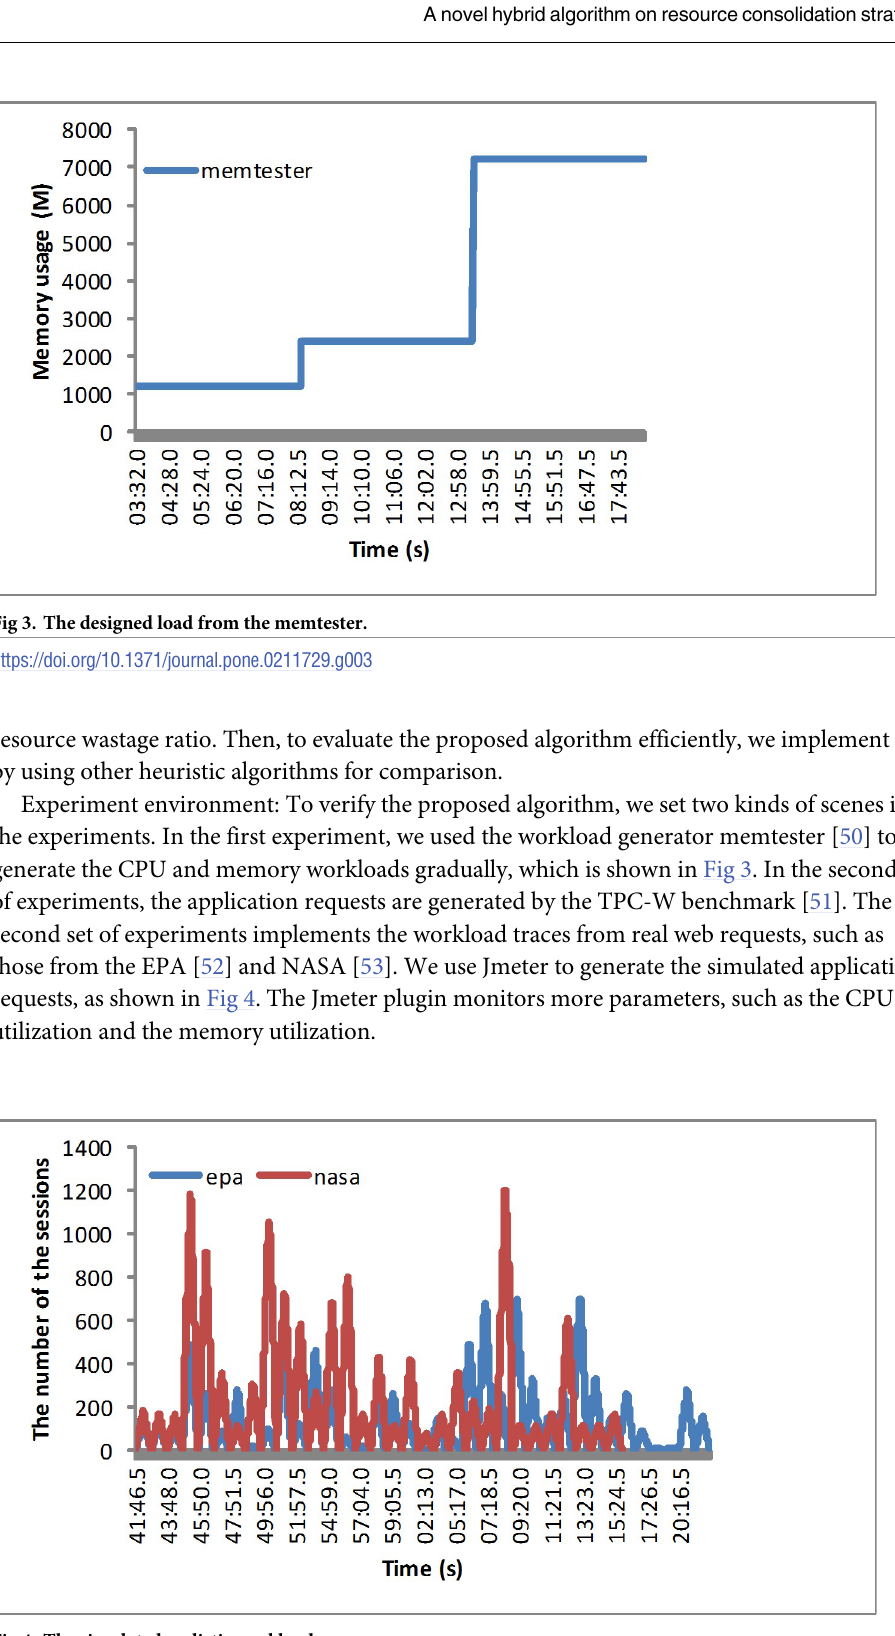
Fig 4. The simulated realistic